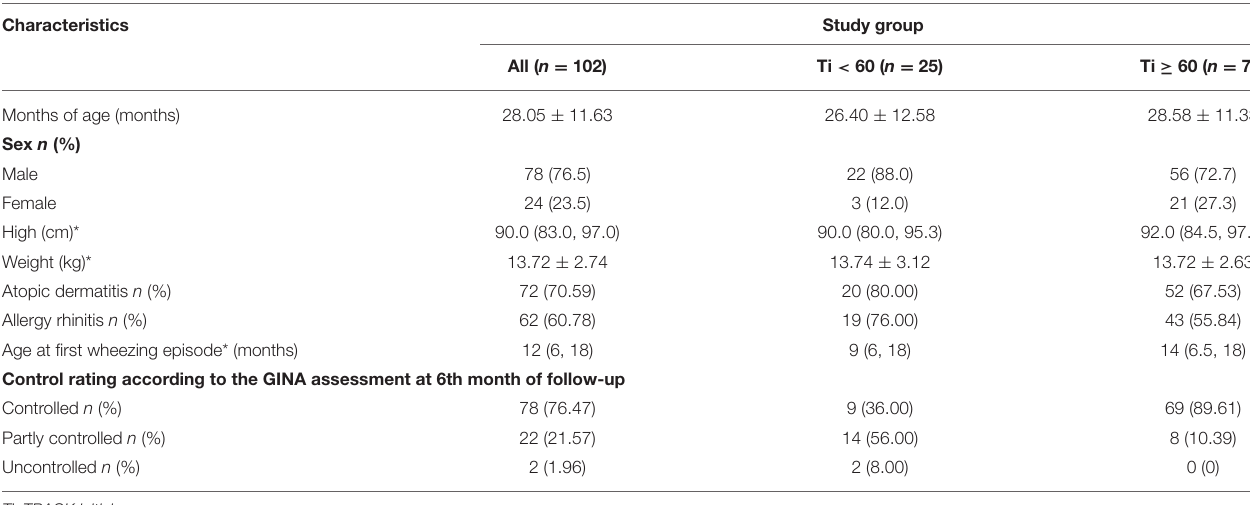
TABLE 1 | Demographic characteristics.